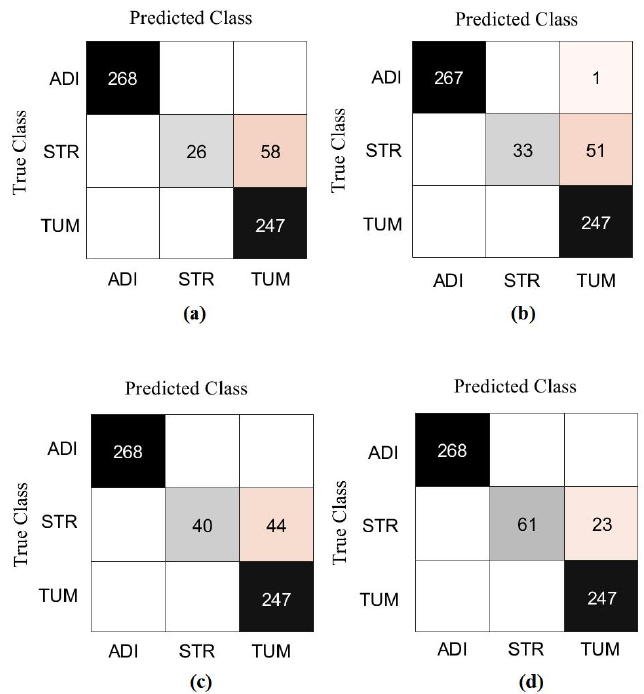
Figure 8. The confusion matrix results of CRC dataset obtained by: ( a ) ResNet-50 pre-trained network,